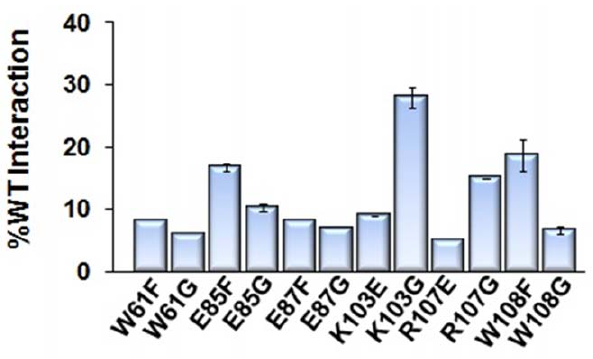
Figure 8. IN dimerization interface mutants exhibit reduced affinity for LEDGF/p75 invitro . An AlphaScreen assay measuring mutant IN interaction with LEDGF/p75, as compared to that of the WT IN-LEDGF/p75 interaction, showed that none of the mutant IN proteins substantially interact with LEDGF/p75. The highest amount of interaction was between K103G and LEDGF/p75, but this protein still only reached about 30% of the WT interaction level.